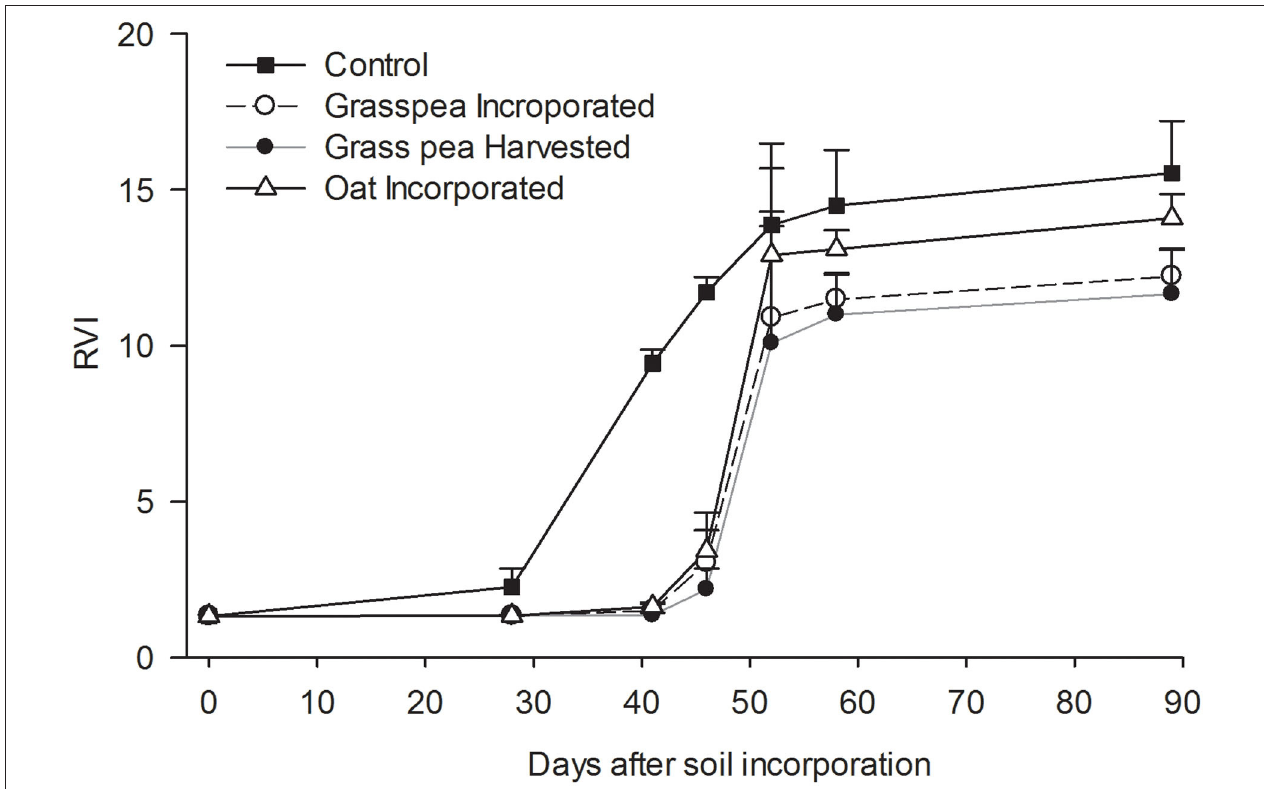
FIGURE 4 | Dynamics of ratio vegetation index (RVI) measured as a proxy for green biomass of crabgrass. Error bars represent standard error ( n = 3). Unidirectional error bars are shown for